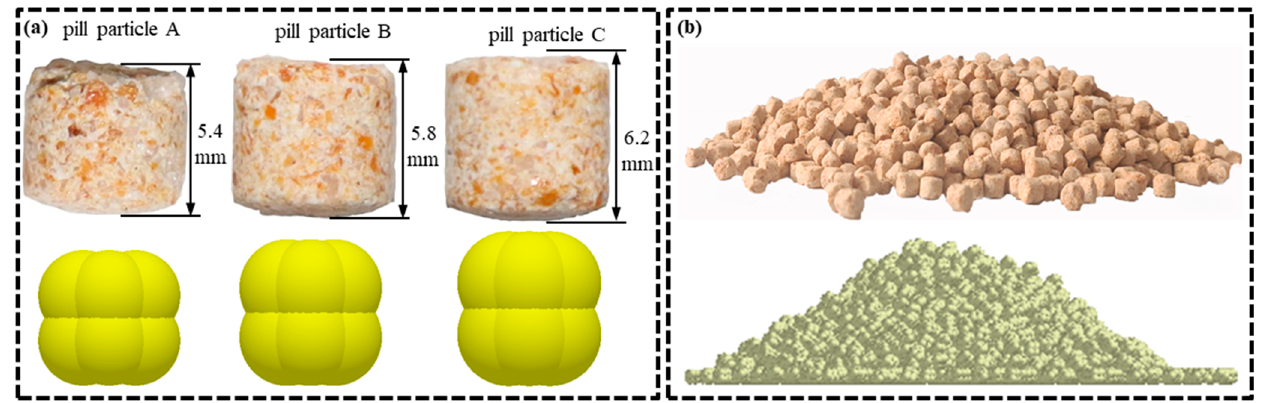
Figure 2. Models of pill particles and angle of repose test: ( a ) hree kinds of pill particles and the DEM models; ( b ) the angle of the repose test and simulation.